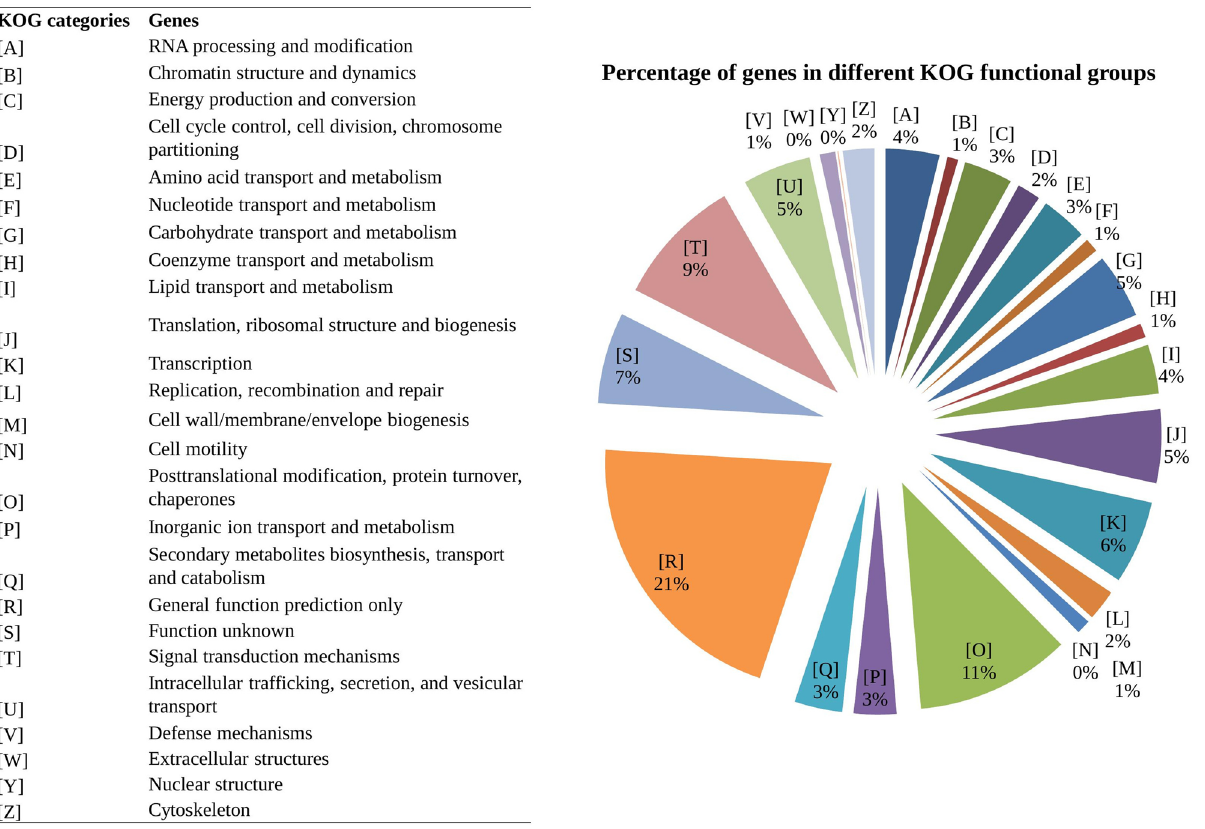
Figure 2. EuKaryotic Orthologous Groups (KOG) functional classification of cashew genome showing the percentage of genes in the 24 functional classes of KOG